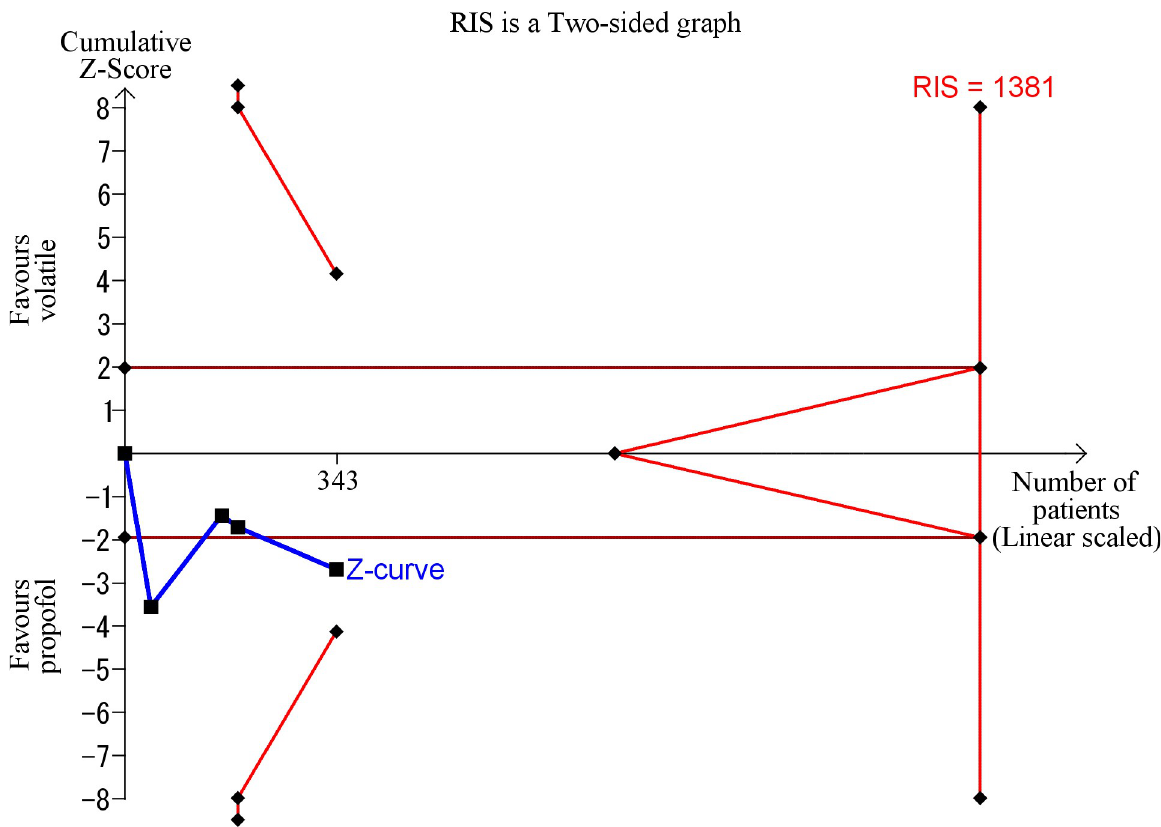
Fig 3. Trial sequential analysis for determining the effect of volatile anesthetics on the amount of bleeding in patients undergoing dilatation and evacuation compared to propofol.